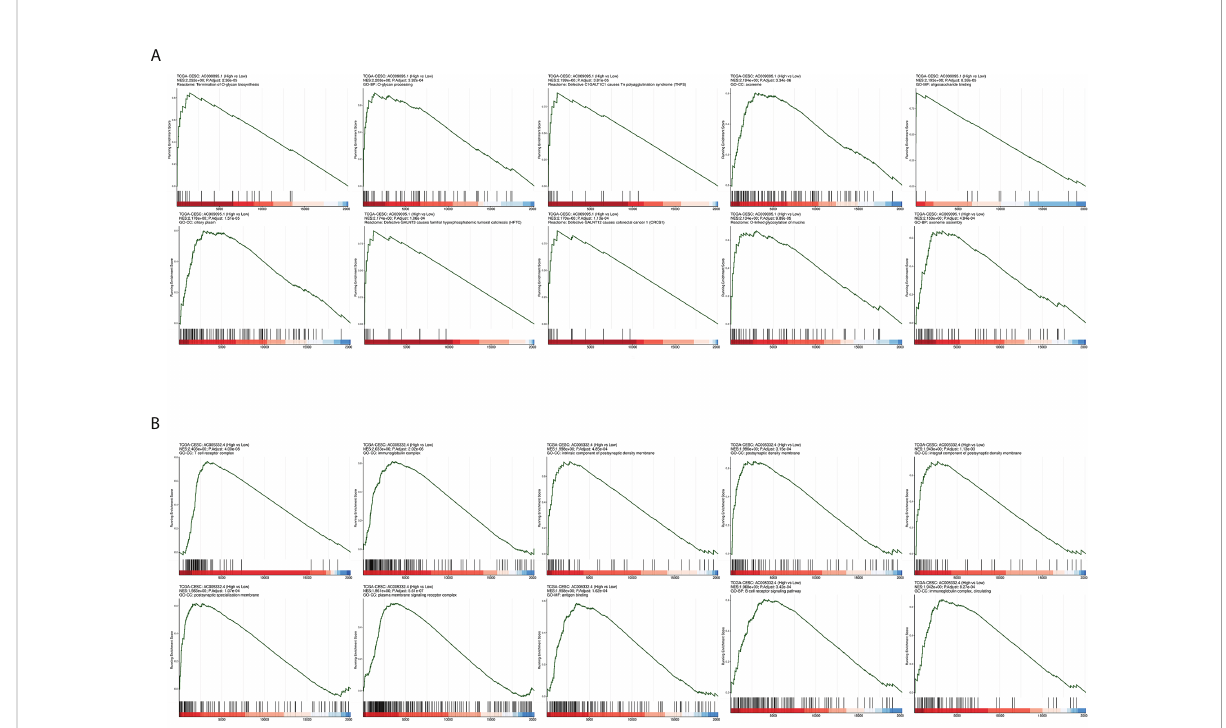
FIGURE 9 Results of GSEA in different groupings of the target lncRNAs in CESC from TCGA database. (A) Results of GSEA in groups of AC009095.1. (B) Results of GSEA in groups of